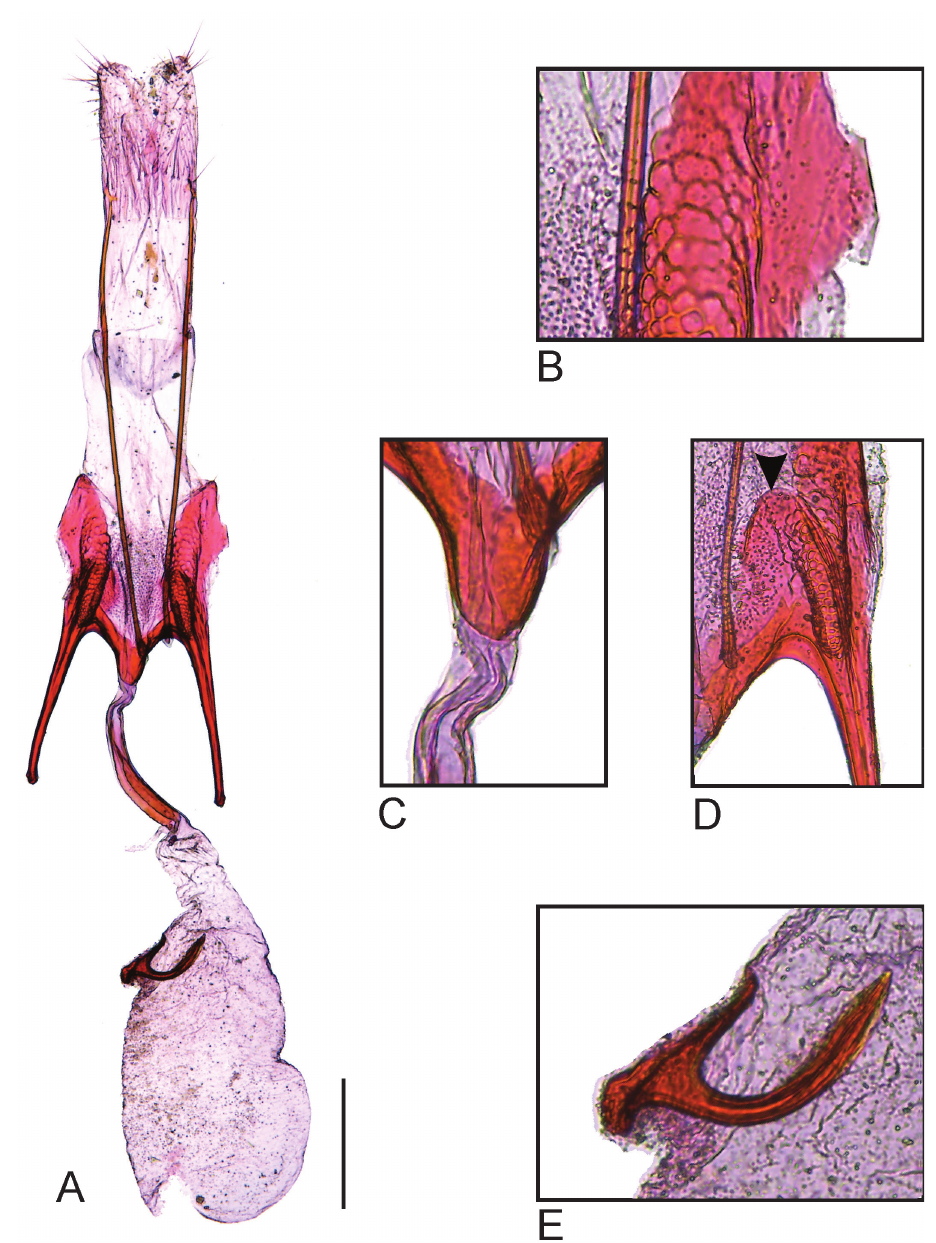
Figure 5. Female genitalia of Scrobipalpulopsis aguilaensis sp. nov. A female genitalia, ventral B detail of right longitudinal sclerite with honeycomb sculpture and membranous area with microtrichia of segment VIII, ventral C antrum, ventral D detail of the flat, semicircular posterior projection of the apophysis anterioris, ventral; black arrow indicates posterior margin E detail of signum, ventral. Scale bar 0.2